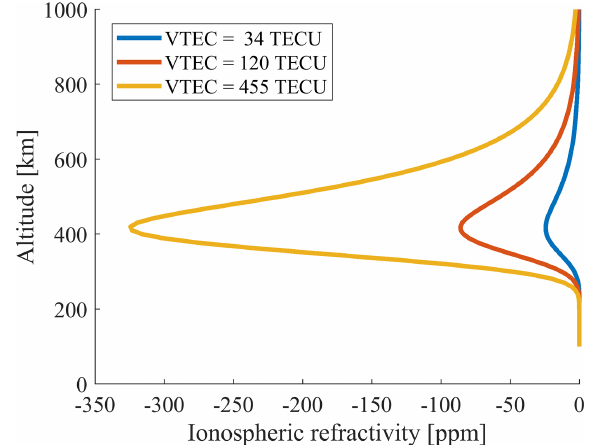
Figure 5. Profiles of ionospheric refractivity N(f ) assuming signal frequency f = 1575 .